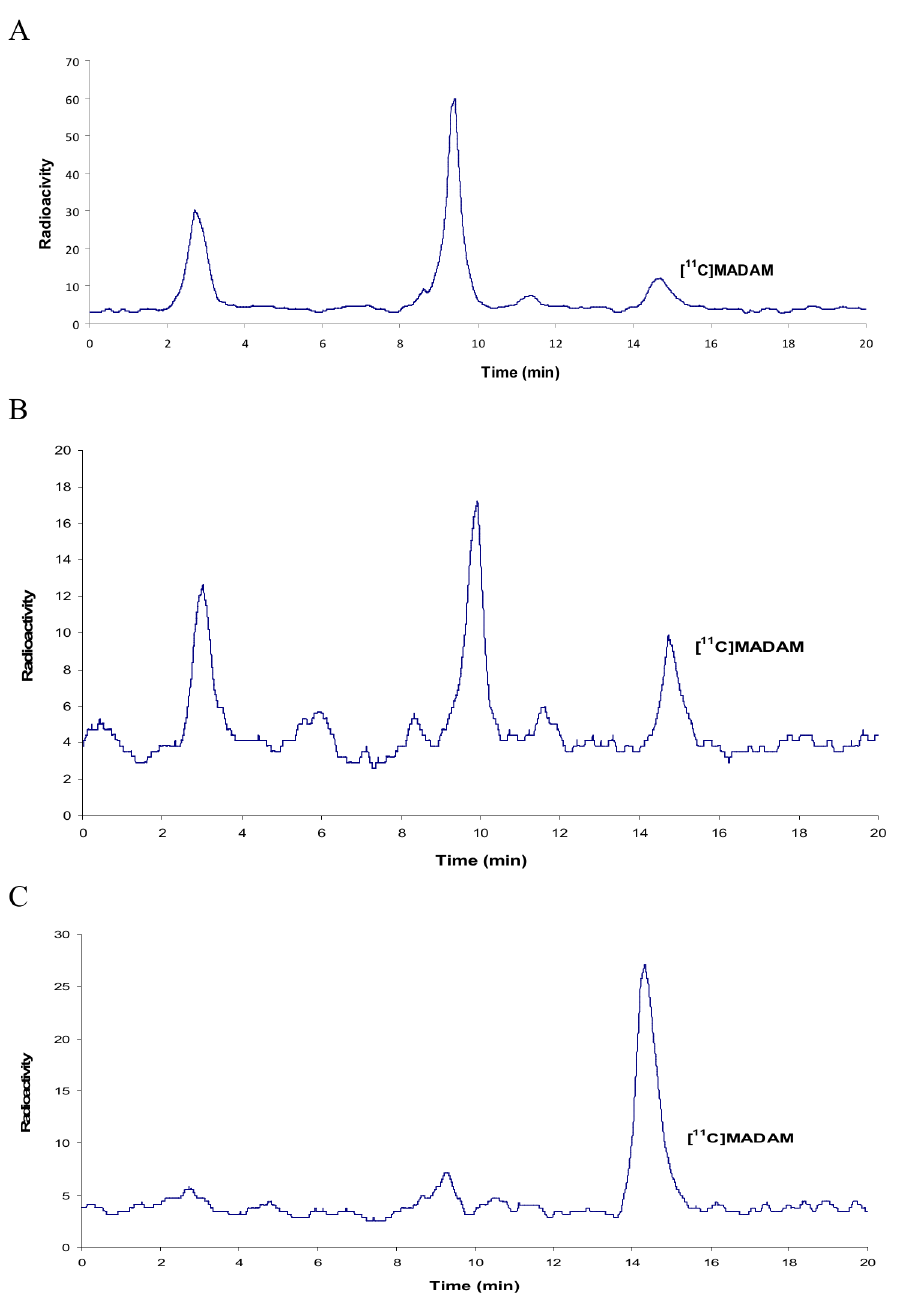
Fig 6. Radio-HPLC chromatograms of rat urine samples after perfusion of (A) [ 11 C]MADAM, (B) [ 11 C] MADAM /MADAM (25 μ g) and (C) [ 11 C]MADAM /MADAM (125 μ g) for 15 min.